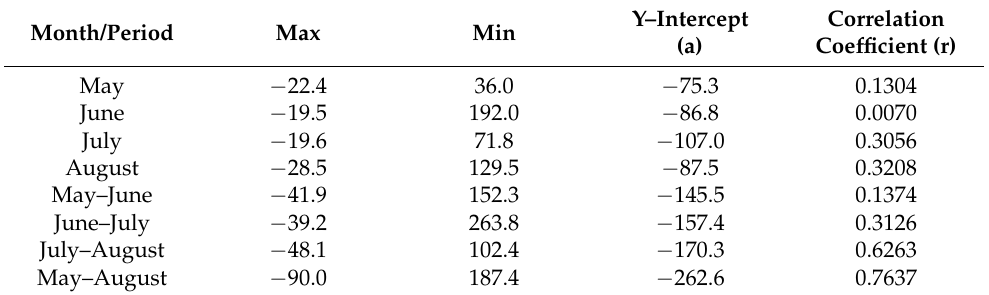
Table 5. Extreme values and regression equations characterizing changes of the agricultural